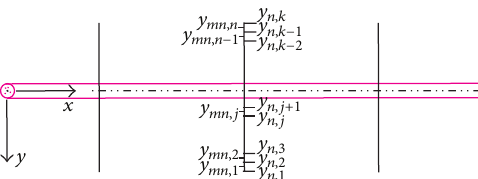
Figure 2: Schematic of multiple transverse fractures along a hori- zontal